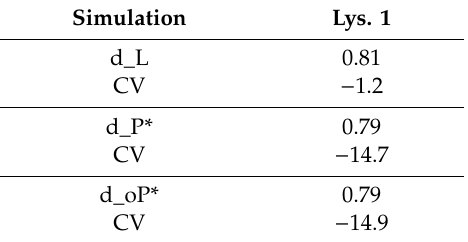
Table 6. E ffi ciency coe ffi cients calculated for daily drainage data on Lys. 1 using